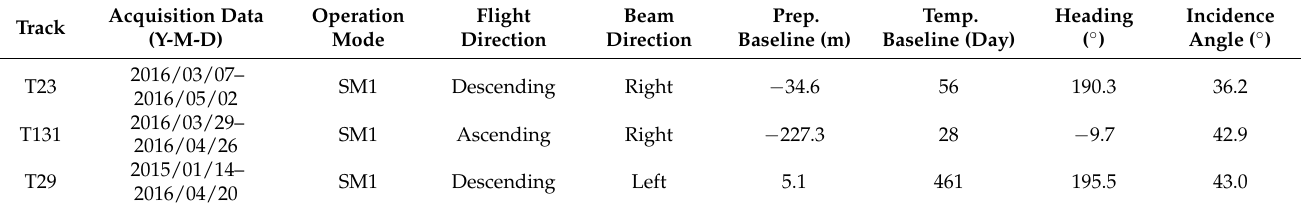
Table 1. Interferometric parameters of the ALOS-2 left- and right-looking images used in this study. Acquisition Data Track